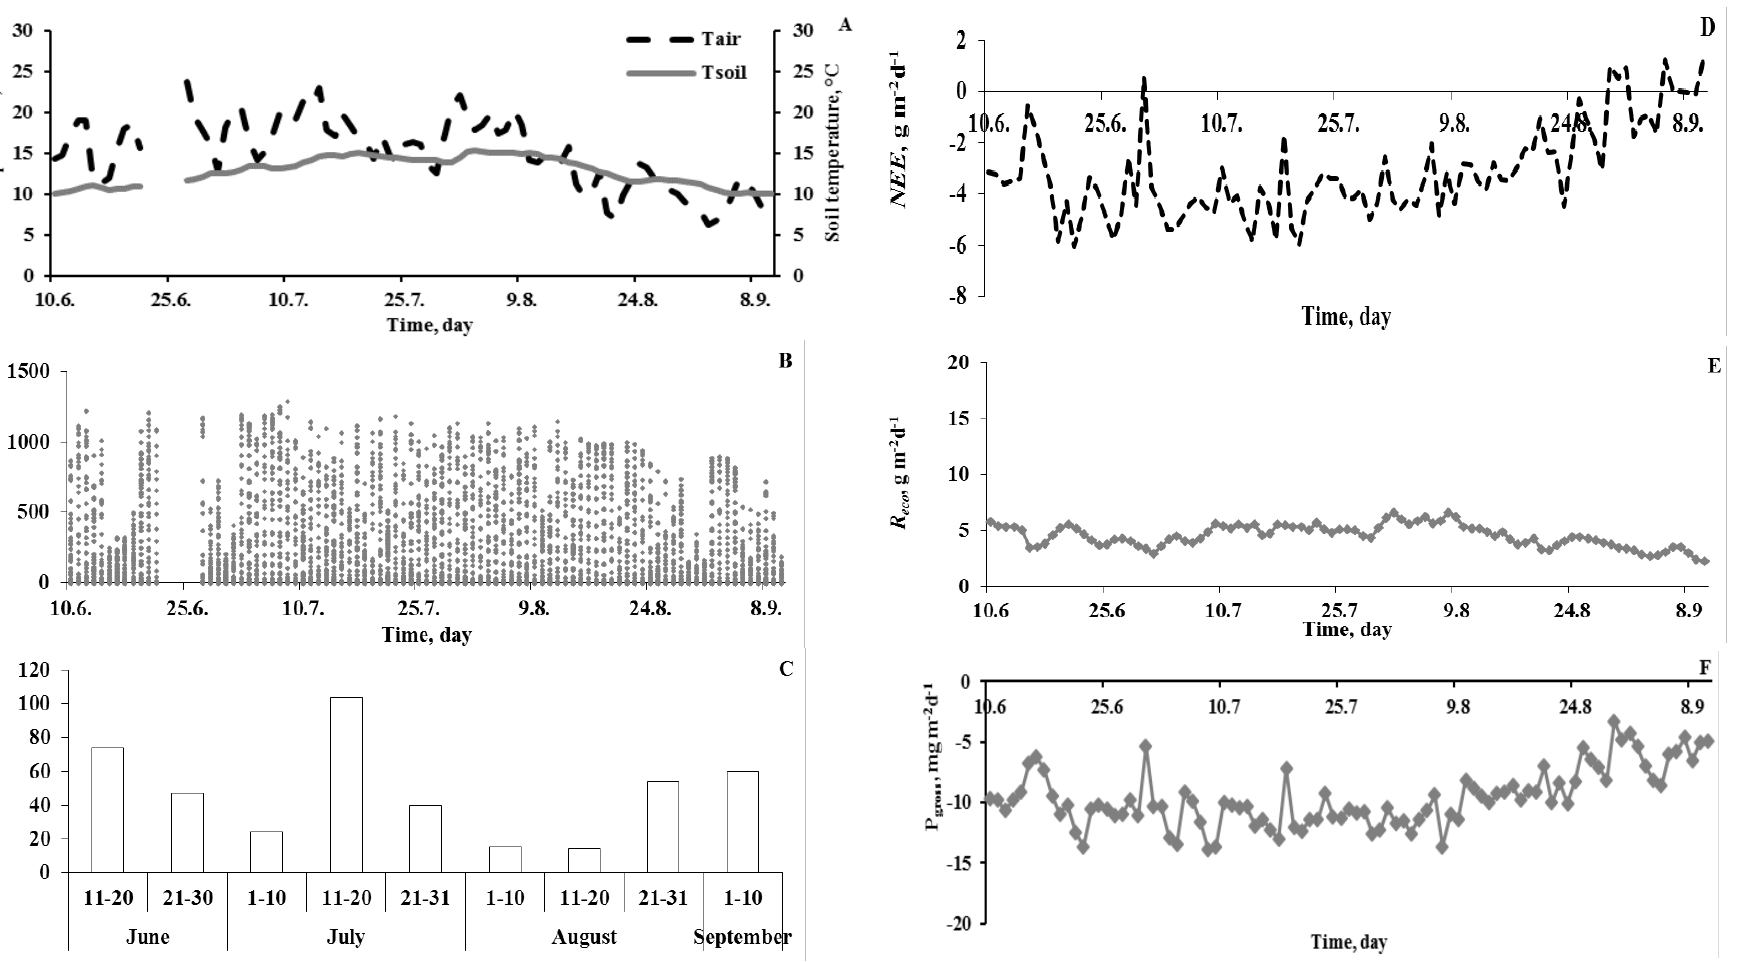
Figure 2. Meteorological conditions and CO (°C); B: PAR intensity (μmol m -2 s -1 ); C: precipitation (mm; each column shows the cumulative rainfall in one-third of a month); D: NEE (g m -2 d -1 ); E: R d -1 ); F: P (g m -2 d -1 gross